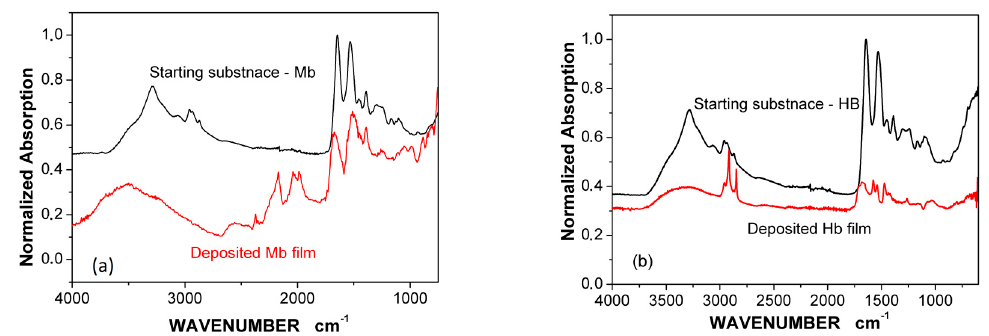
Figure 3. FTIR spectra of the starting substance and: ( a ) the deposited Mb film; ( b ) the deposited Hb film.